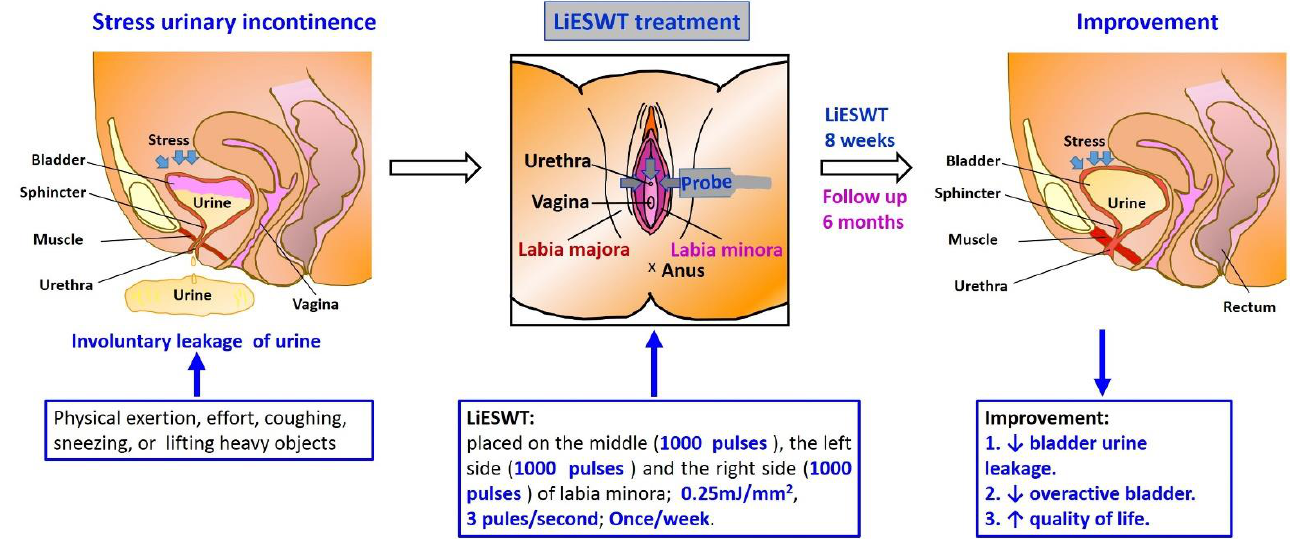
Figure 4. Short graphic abstract of studying the proposed potential effect of LiESWT. SUI, stress urinary incontinence; LiESWT, low intensity extracorporeal low energy shock wave therapy.